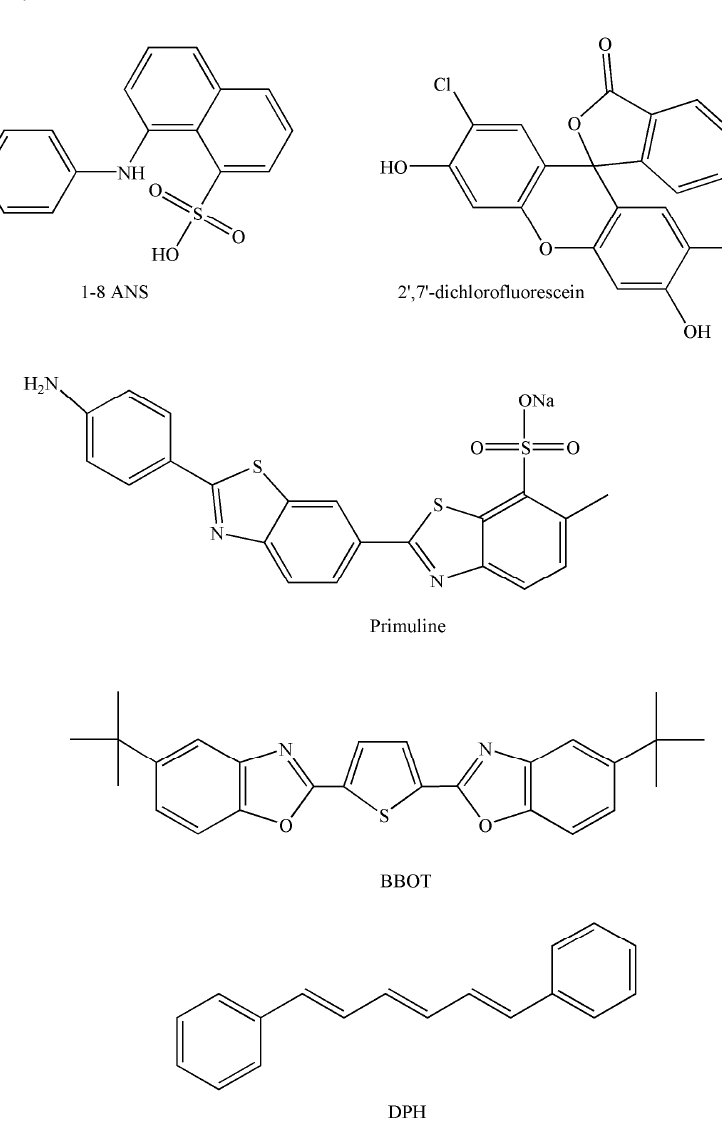
Figure 5. General chemical structures of molecular probes used for TLC and HPLC post- column